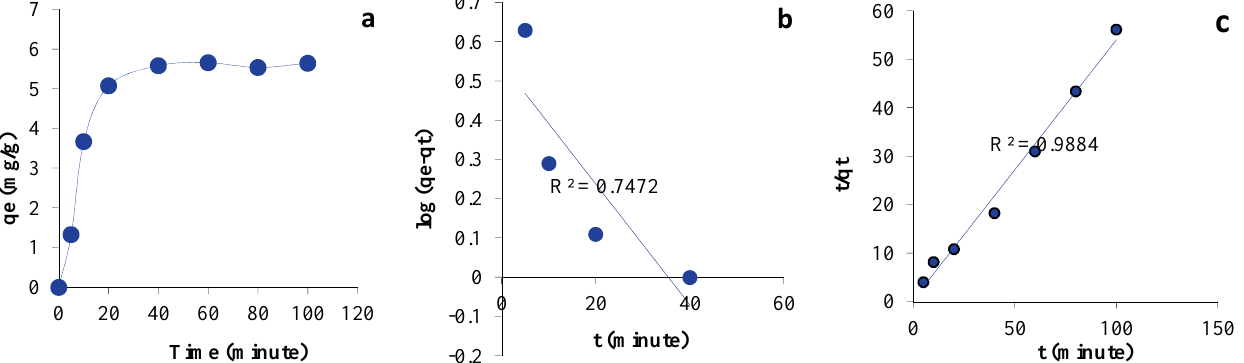
Figure 2. (a) Effect of contact time on the sorption of 4-CP (adsorbent dosage = 3 g/l, and initial concentration = 20 mg/l at the initial solution pH), and (b) pseudo-first order and (c) pseudo-second order kinetic